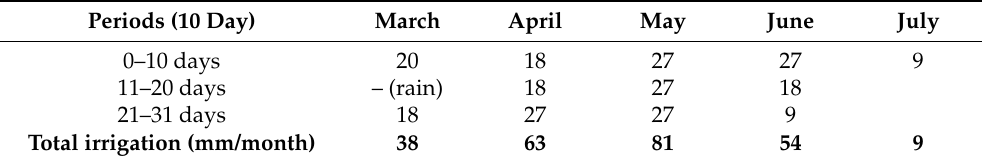
Table 6. Total irrigation water (mm) applied in each irrigation during the crop growing period